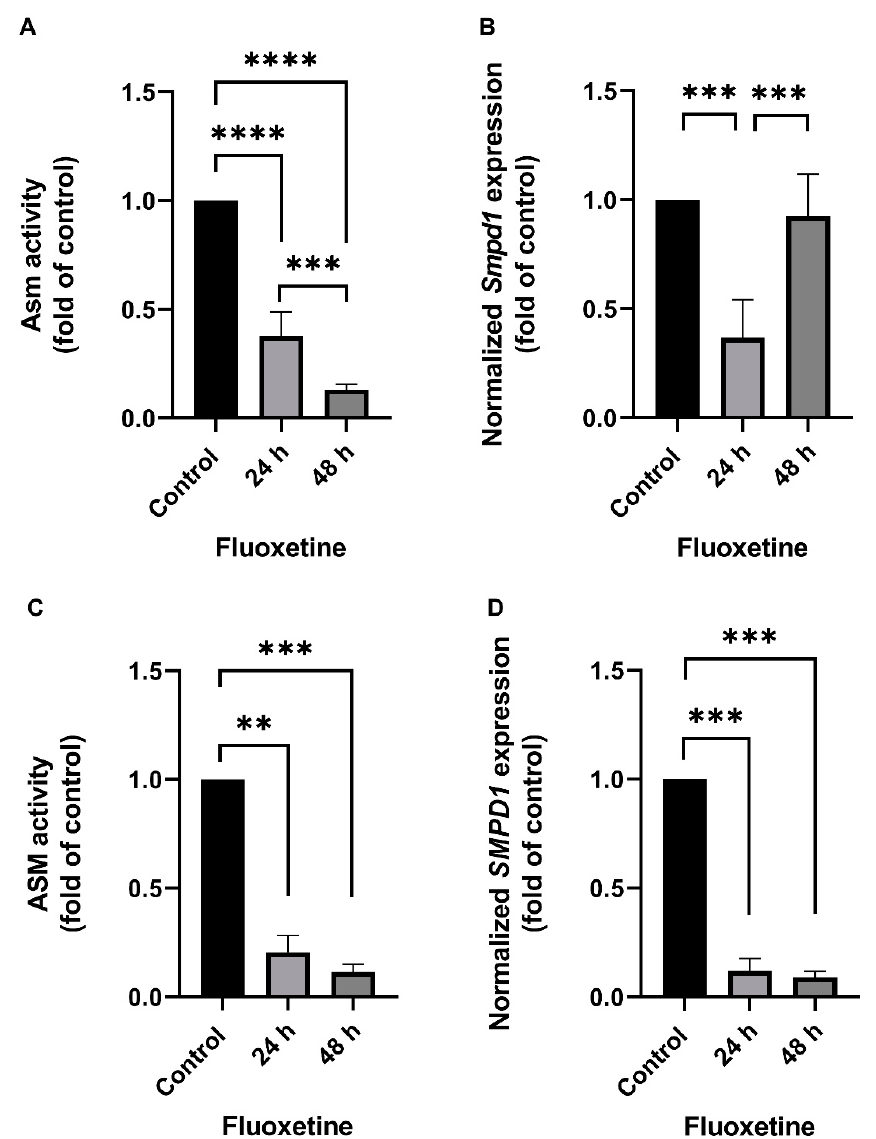
Figure 1. Fluoxetine decreases both ASM activity and SMPD1 mRNA expression in cultured primary cells. Cultured primary cells were treated a single time with 10 µ M fluoxetine and harvested after 24 h or 48 h. ( A ) Asm activity in murine cortical neurons. Fluoxetine inhibited Asm activity at both time points significantly; ( B ) Smpd1 transcription in murine cortical neurons. Transcription was significantly decreased at 24 h after the single fluoxetine application but was similar to the control at 48 h, N = 5 independent cortex preparations; ( C ) ASM activity in human PBMCs. Fluoxetine inhibited ASM activity at both time points significantly; ( D ) SMPD1 transcription in human PBMCs. A single stimulation with fluoxetine significantly decreased transcription at both time points. N = 2 independent PBMC preparations, measured in triplicate. Data represent the mean and SD; ** p < 0.01, *** p < 0.001, **** p <